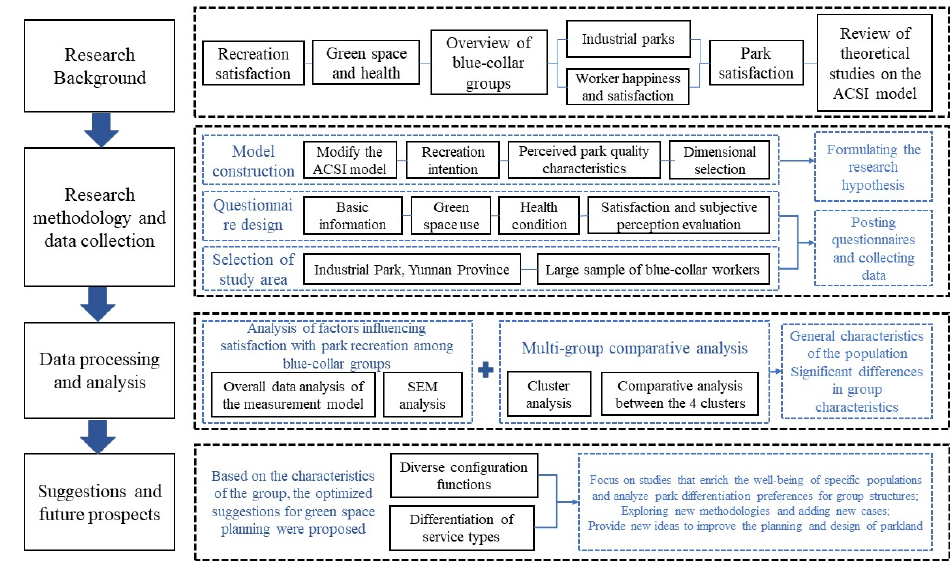
Figure 1. Research structure.